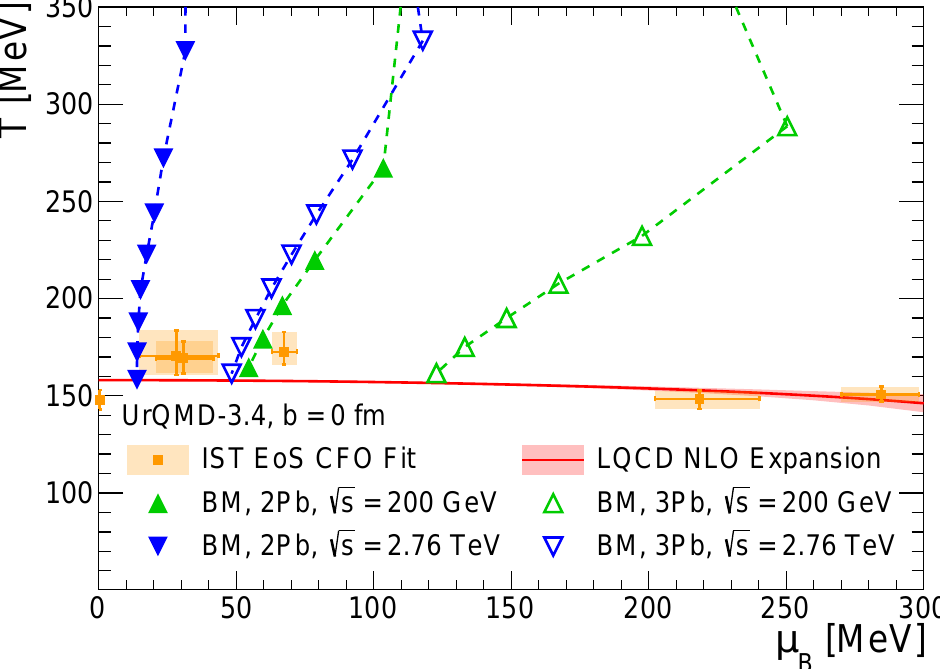
Figure 8. The evolution of central cell parameters in the T − µ B plane obtained with the MIT bag model equation of state [45]. The filled symbols correspond to the Pb+Pb collisions, whereas √ s NN = 200 GeV points the empty ones correspond to the Pb+Pb+Pb TNC. Collision energy are shown by the triangles pointing upwards, whereas the evolution trajectories for the energy √ s NN = 2.76 TeV are shown by the triangles pointing downwards. The topmost points correspond to the time t − t 0 > 1 fm. The curve of pseudo-critical temperature corresponds to a lattice QCD parameterization [48], whereas the crosses correspond to the parameters of chemical freeze-out in Pb+Pb collisions found in Refs. [49–51]. The collision energies of given chemical freeze-out points of √ s NN = 2760,200,130,62.4,17.3,12.3 GeV Pb+Pb collisions are as follows (from left to right):